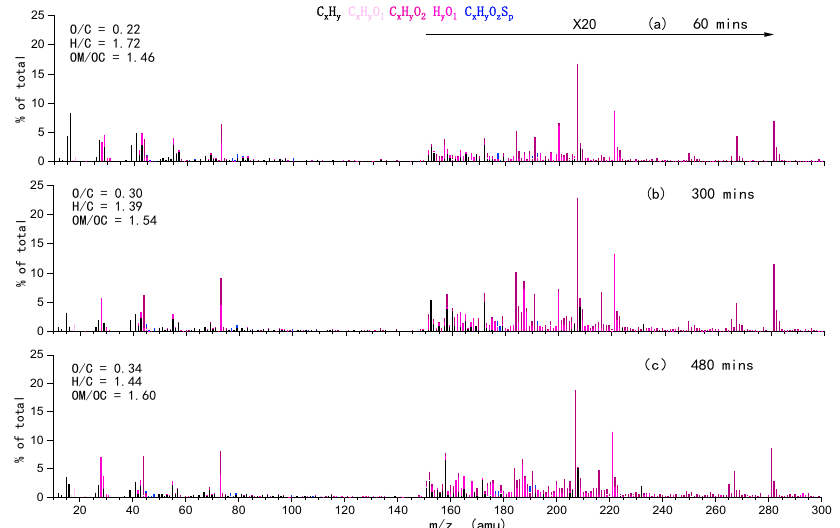
Figure 3. Examples of high-resolution mass spectra of the organics determined by the soot particle aerosol mass spectrometer (SP-AMS) during OH-mediated aqueous oxidation at different times: ( a ) 60 min, ( b ) 300min, and ( c ) 480 min.